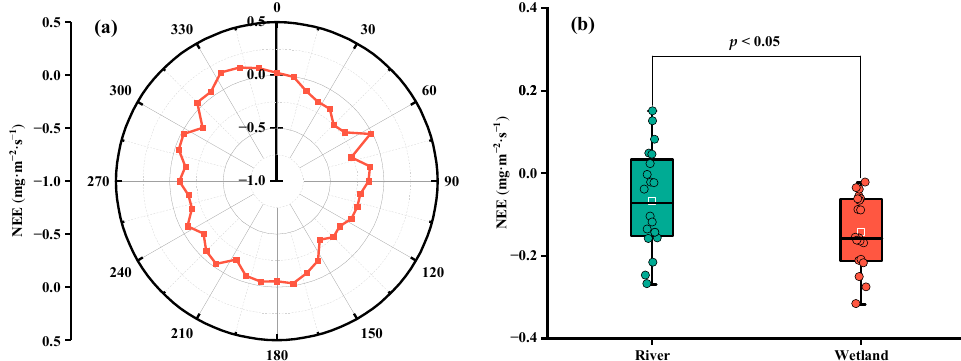
Figure 3. ( a ): NEE in each wind direction. ( b ): NEE in river and artificial wetland regions.